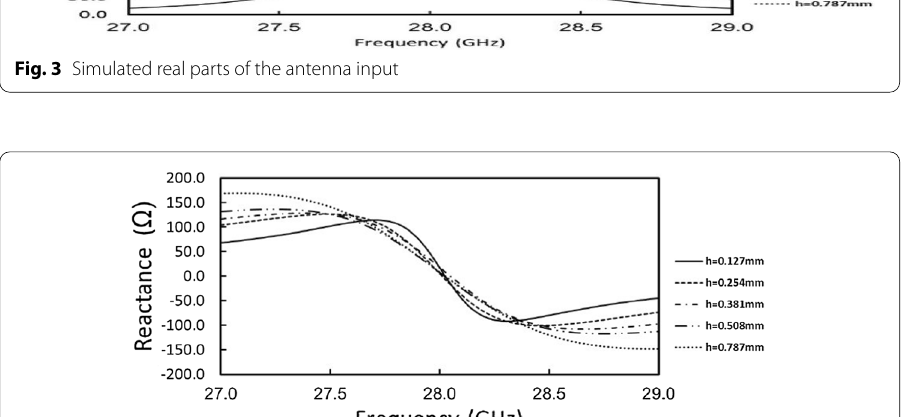
Fig. 4 Simulated imaginary parts performance of the antenna input impedance for five different substrate